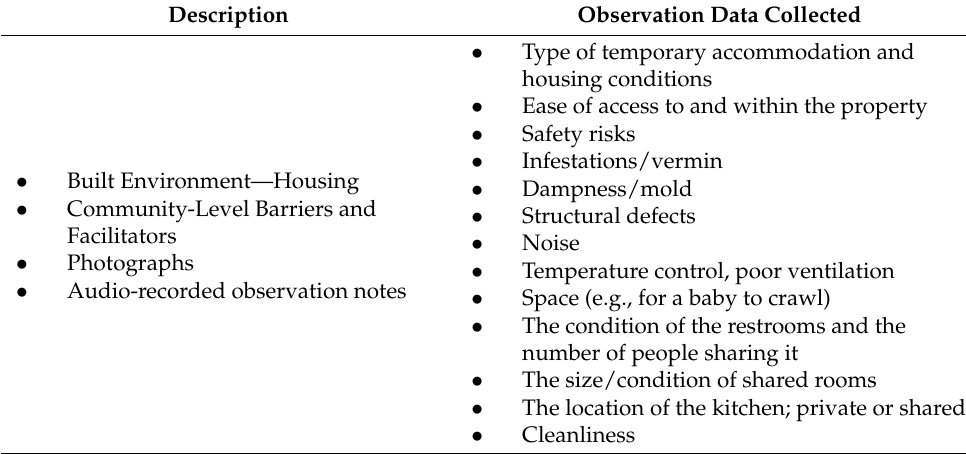
Table 1. Observation data collected in house